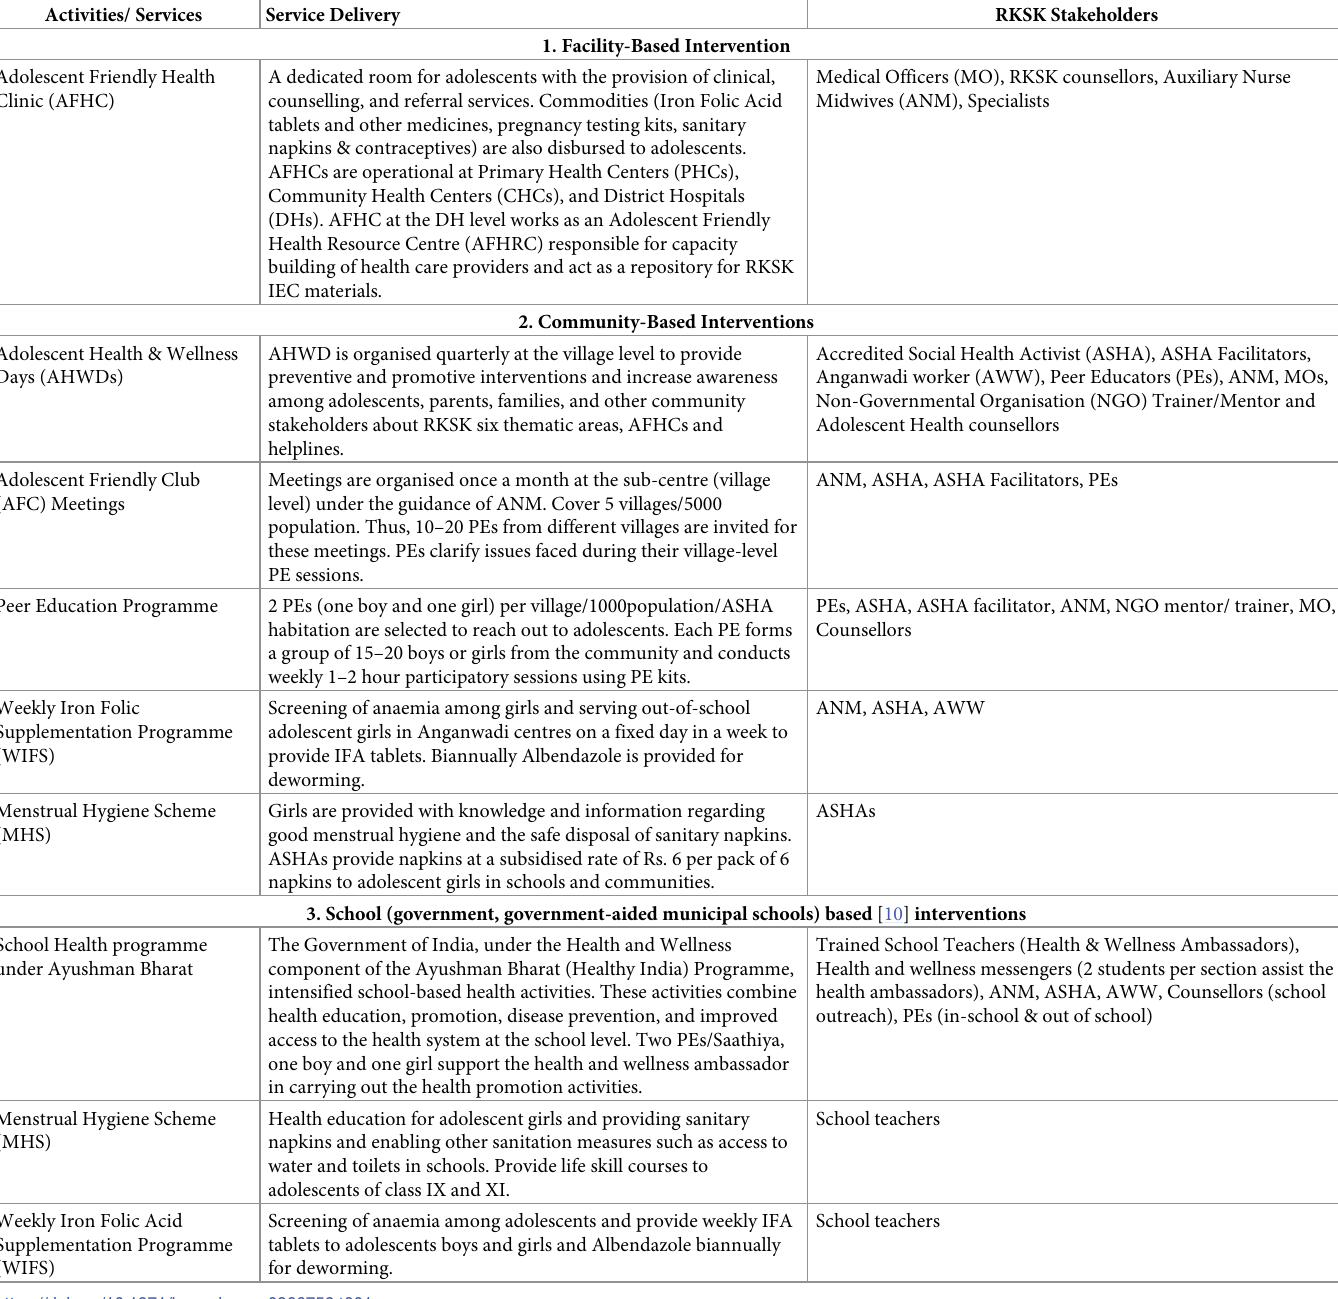
Table 1. Overview of RKSK interventions and health workers [8, 9] involved in programme